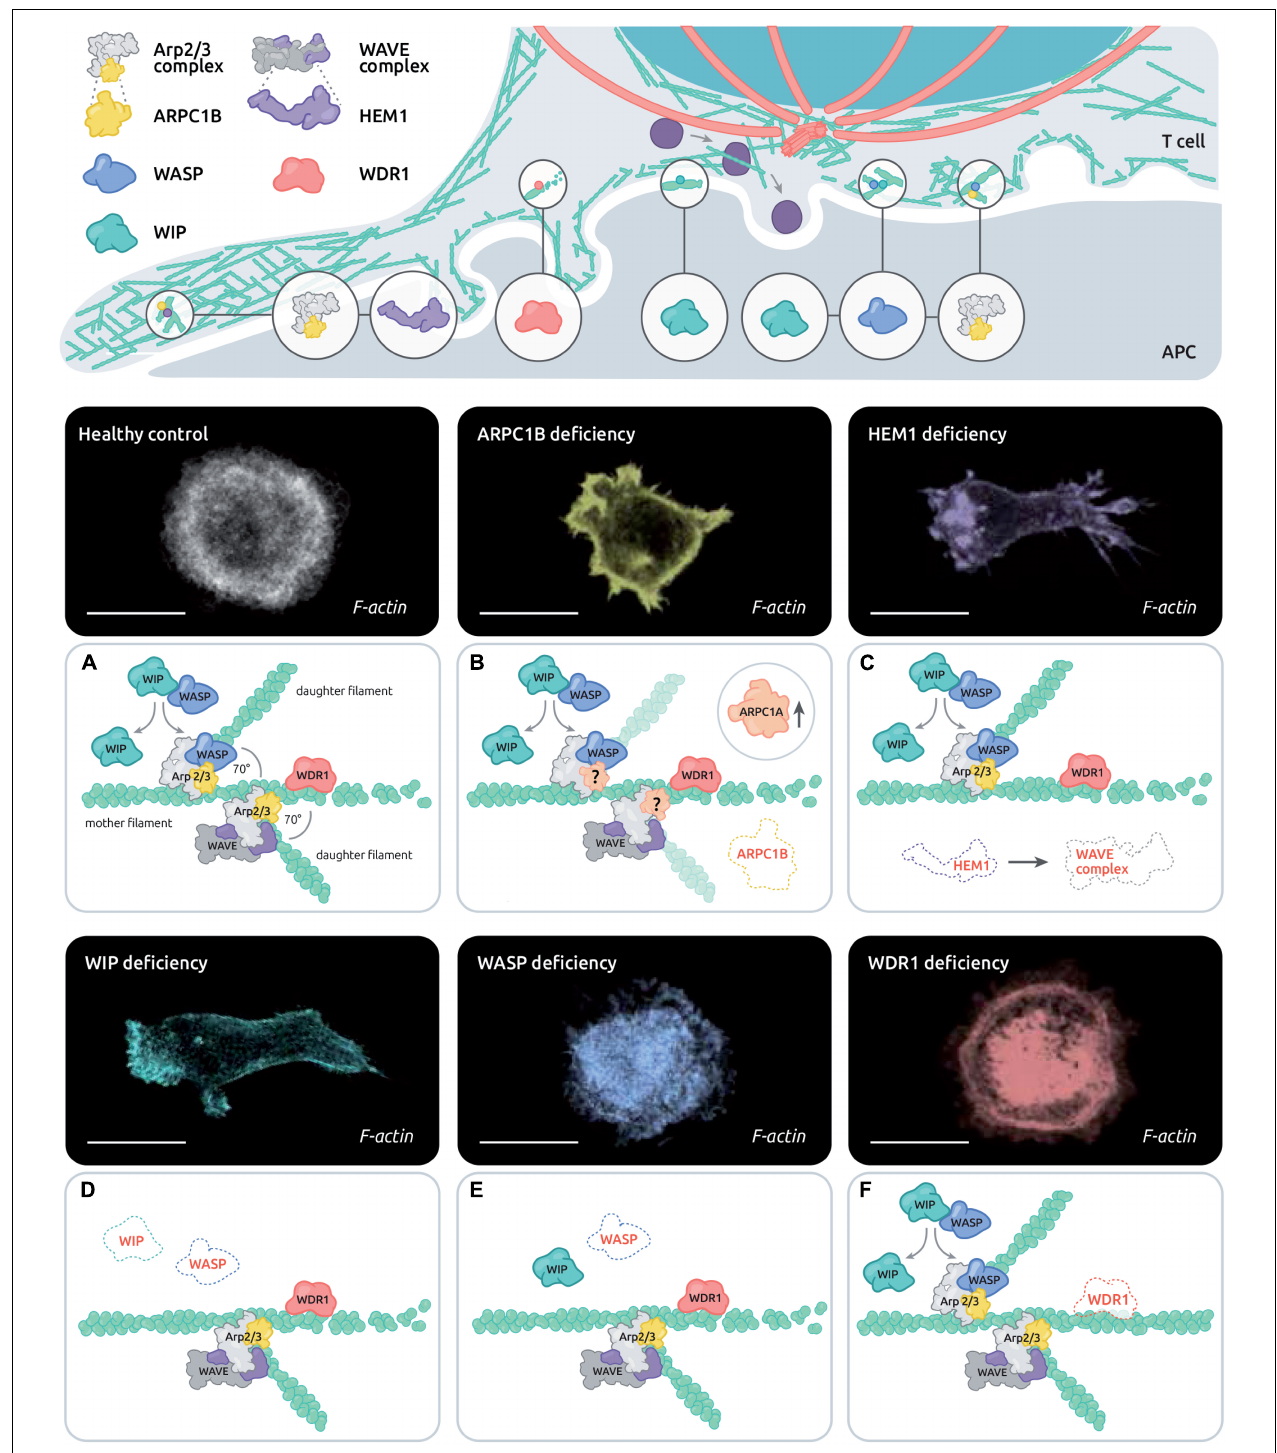
FIGURE 2 | Control of actin remodeling at the T cell synapse by the disease-related actin-binding proteins ARPC1B, HEM1, WASP, WIP and WDR1. The upper scheme depicts the estimated distribution of PID associated actin-binding proteins in the various actin networks of the IS. The lower panels combine representative T cells stained with phalloidin and the corresponding molecular alterations in the context of healthy T cells (A) , ARPC1B deficiency (B) , HEM1 deficiency (C) , WASP deficiency (D) , WIP deficiency (E) , and WDR1 deficiency (F) . Scale bar: 10 µ m.